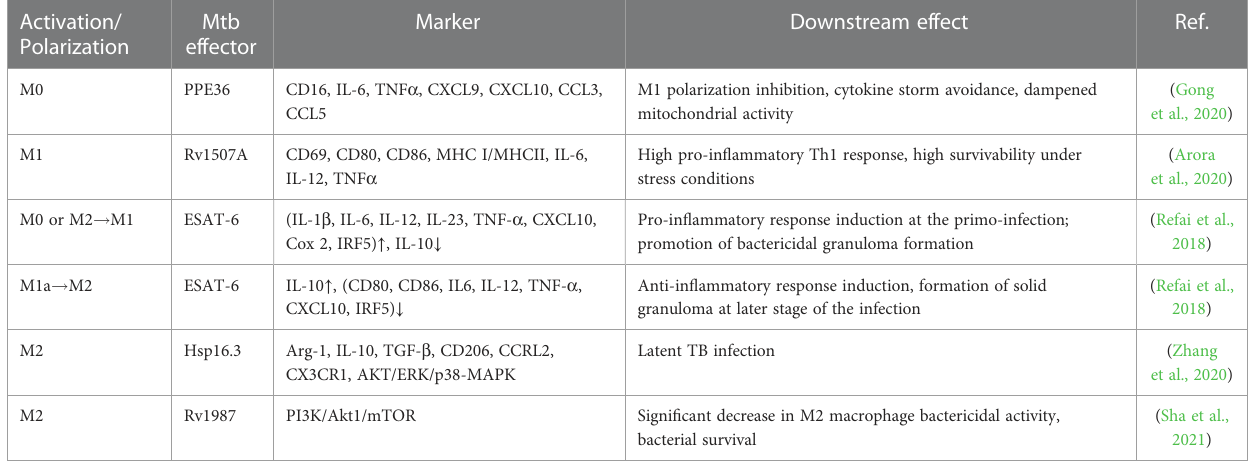
TABLE 2 Recent Mtb stimuli polarizing host